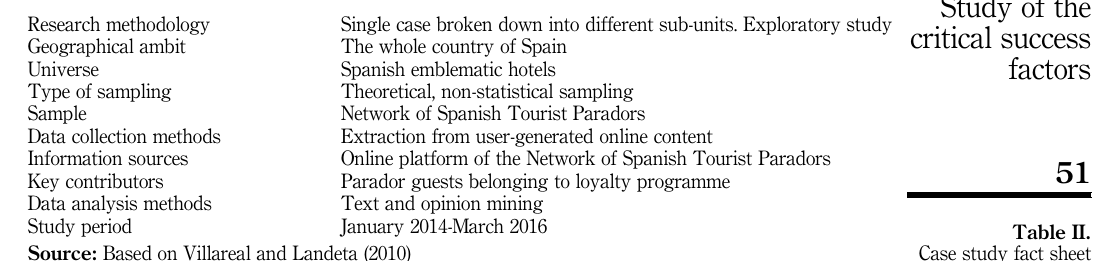
Table II. Case study fact